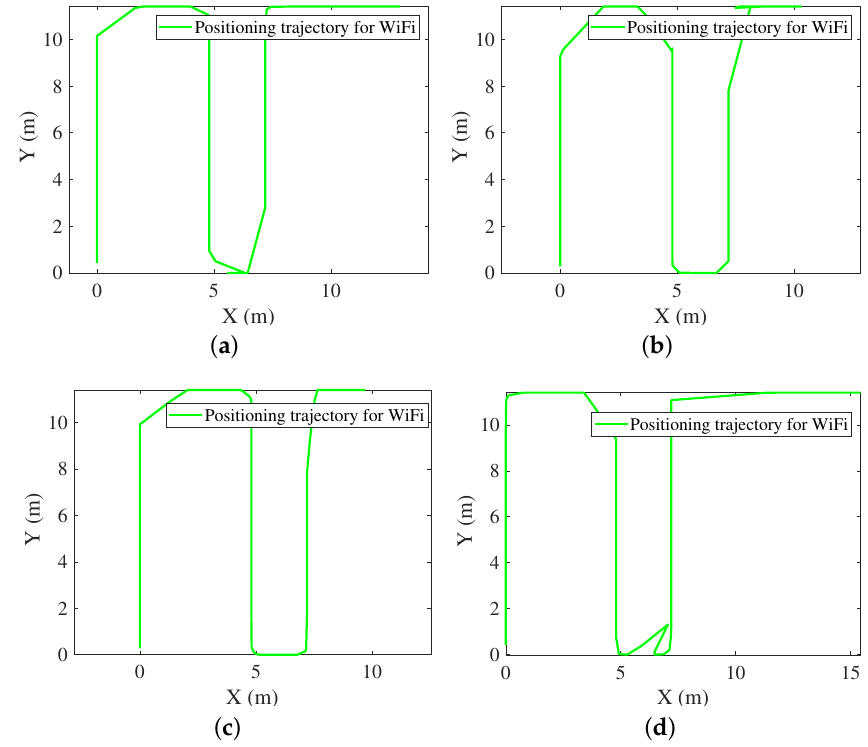
Figure 5. Navigation trajectories for WiFi. ( a ) Calling mode. ( b ) Dangling mode. ( c ) Handheld mode. ( d ) Pocketed mode.